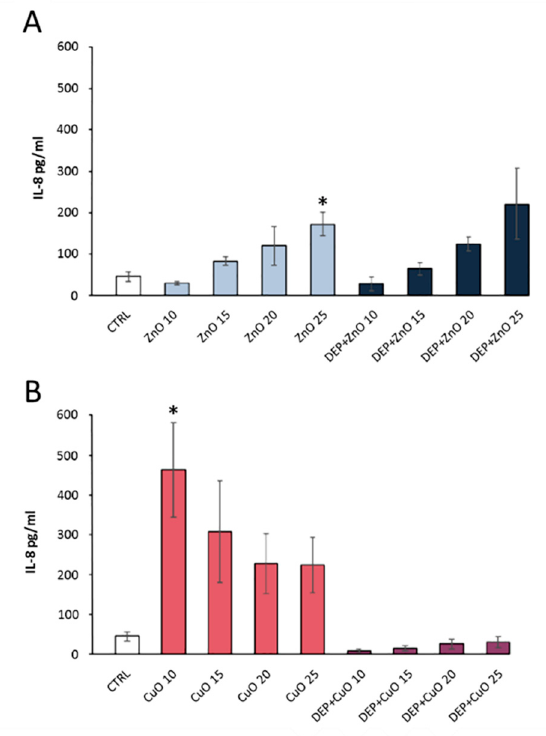
Figure 6. Analysis of the pro-inflammatory interleukin (IL)8 cytokine release in A549 cells after exposure to ZnO ( A ) and CuO ( B ) nanoparticles alone or in combination with diesel exhaust particles. * Statistically significant according to the unpaired t test; p<0.05. Reproduced with the permission from [52].